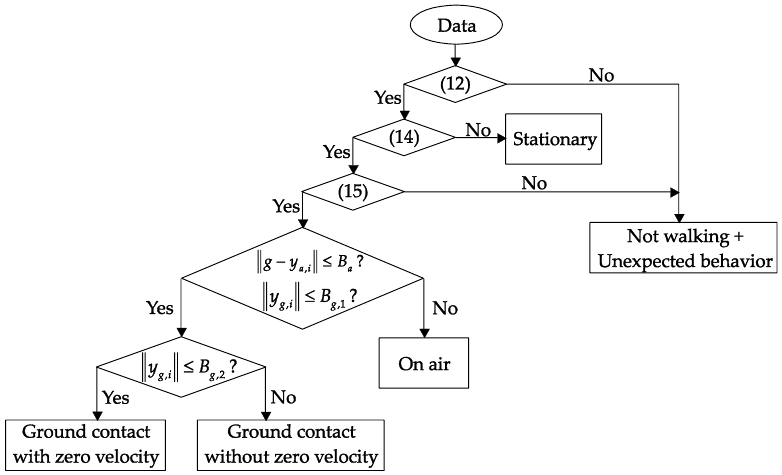
Figure 13. Flowchart of walking phase classification for a standard cane.